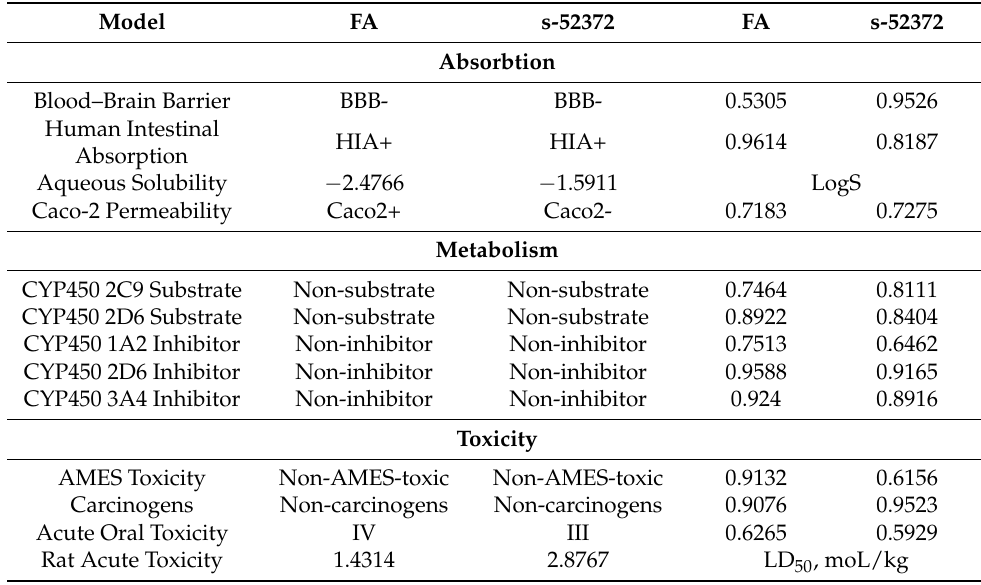
Table 2. Computer prediction of the related properties of S-52372 and